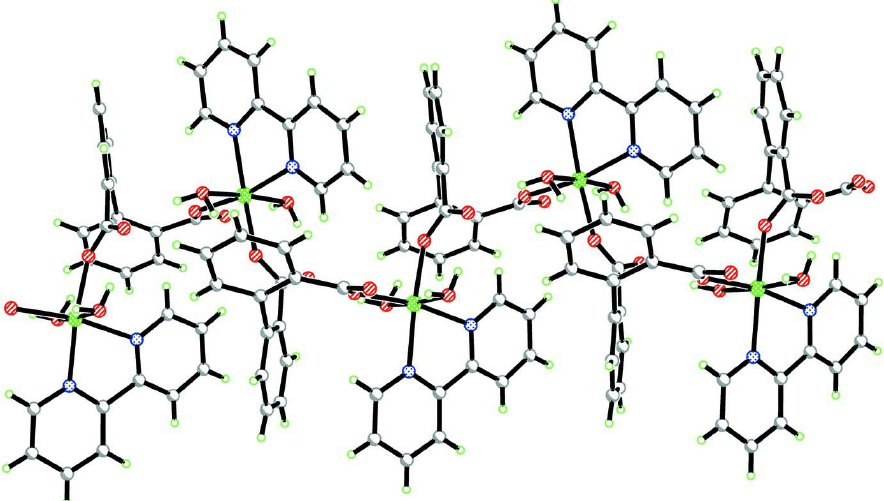
Figure 2 1-D coordination polymer running along the [100]